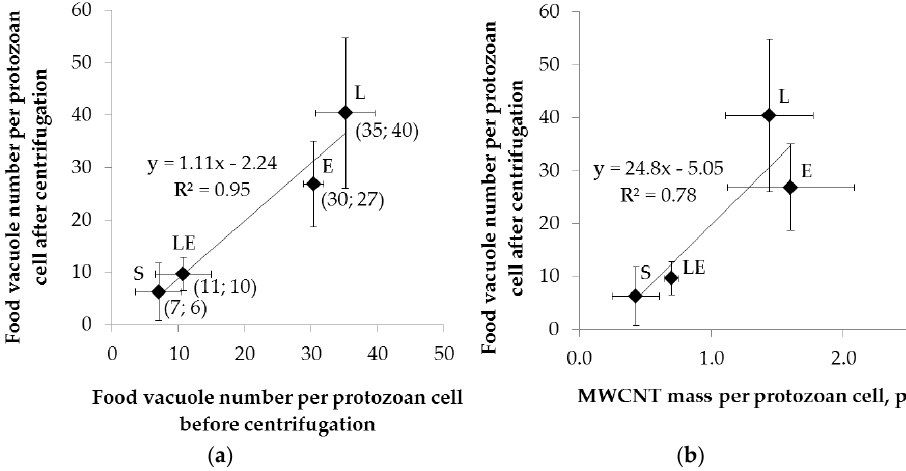
Figure 6. ( a ) Comparison of food vacuole numbers in protozoan cells before and after differential and density gradient centrifugations; and ( b ) correlation between the food vacuole numbers and MWCNT mass per protozoan cell when sampled at four different growth phases (indicated by the letters: L—lag phase, E—exponential phase, LE—late exponential phase and S—stationary phase). Numbers at each data point in panel ( a ) indicate mean food vacuole numbers before and after centrifugation ( x ; y ), which were not statistically different based on the two ‐ sample t ‐ test ( p ≤ 0.05) for each of the growth phases. Food vacuole numbers per cell are the mean values of 5 to 11 individual cells. MWCNT masses are based on the mean values of three LSC measurements of 14 C associated with radiolabeled MWCNTs. Error bars indicate standard deviations.